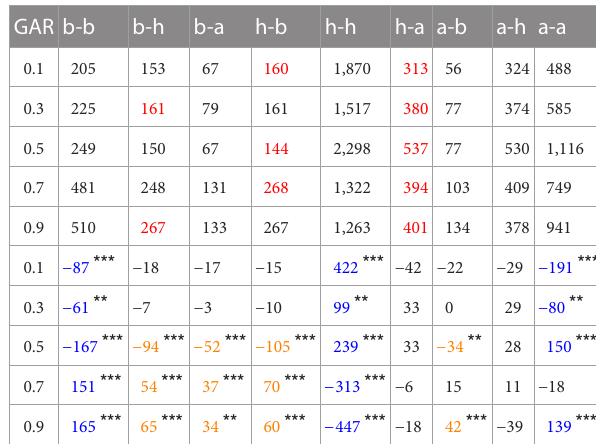
TABLE3 Top:observedtransitioncountsbetweentheROIsbody(b),head (h),andgazeaverted(a).Bottom:differencesintransitioncounts (observed−expected)forthetransitionsbetweentheROIsbody(b),head(h), andgazeaverted(a)perGARcondition.Theadjusted α levelis0.00 ̇ 1